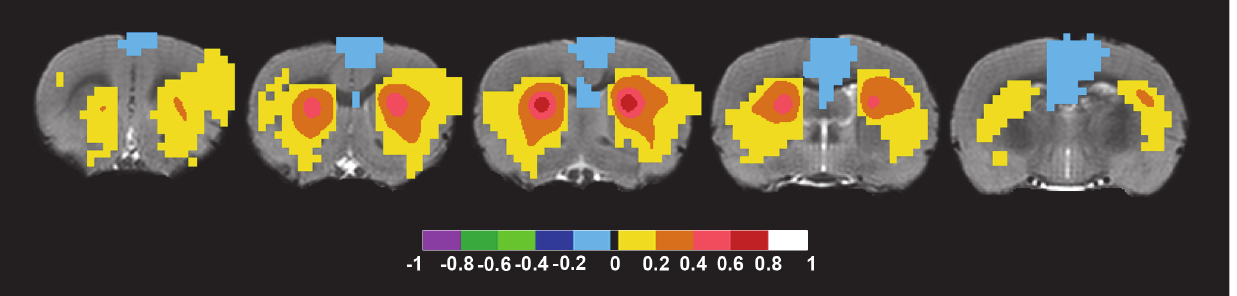
Fig 6. Rat Dorsal Basal Ganglia Network. To define this network, a bilateral seed was placed at approximately Bregma in mm: +/-3.5; 4; -0.3. Axial rat brain images are sorted from left to right in rostral to caudal order. The images from the far left to the right all show bilateral positive FC-values bilateral caudate putamen and week positive FC-values in the rostral somatosensory cortex in the three images to the left. Note that all images also includes an anticorrelated caudal cingulate gyrus region. FC-values are displayed with a pseudo-colored scale bar; with increments of 0.2 each designated a color (see the color-bar in the image).